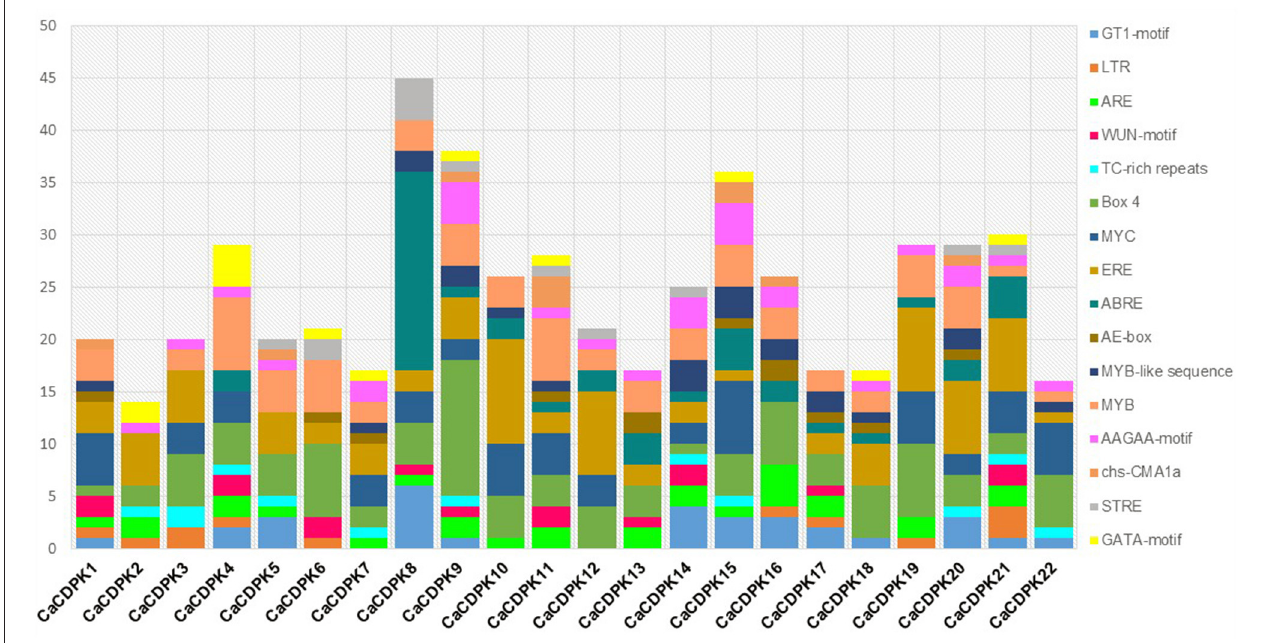
FIGURE 6 | Promoter analysis of chickpea CDPK genes. Different cis -regulatory elements in the 2kb upstream promoter region of CaCDPK genes are illustrated by different colors in the bar chart. The X-axis represents the name of genes and Y-axis represents the number of different cis -elements in each promoter. The names of cis-regulatory elements are mentioned on the